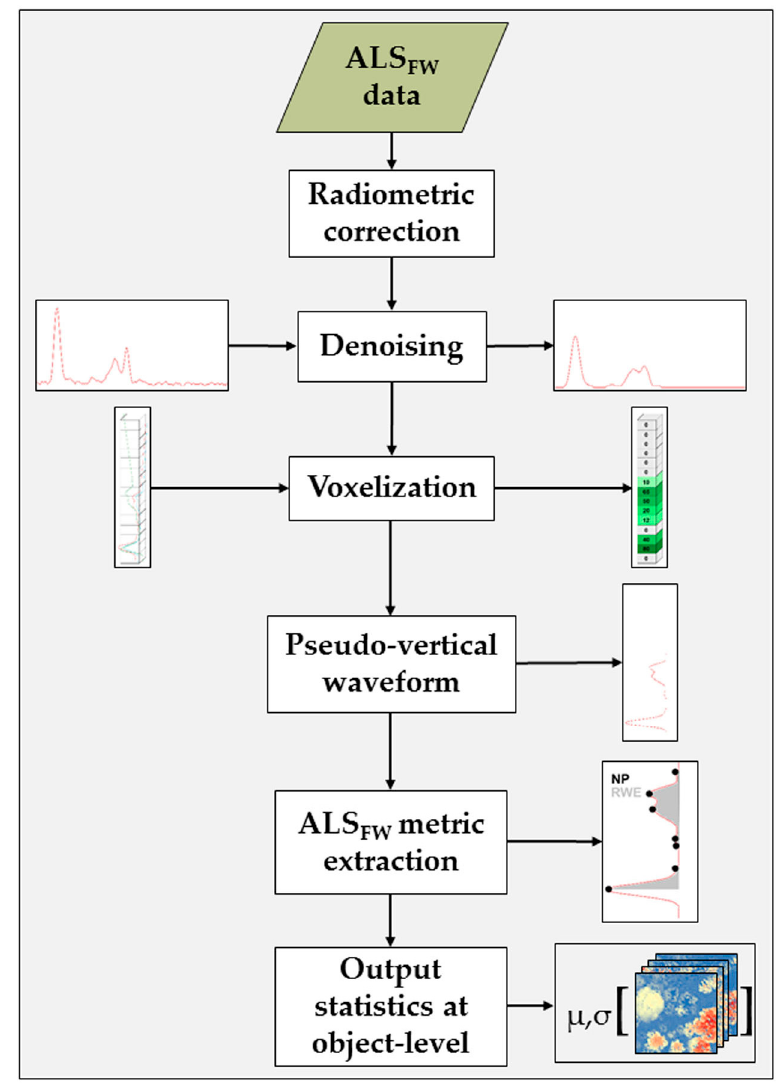
Figure 1. Overall process to extract full-waveform airborne laser scanning (ALS FW ) metrics.